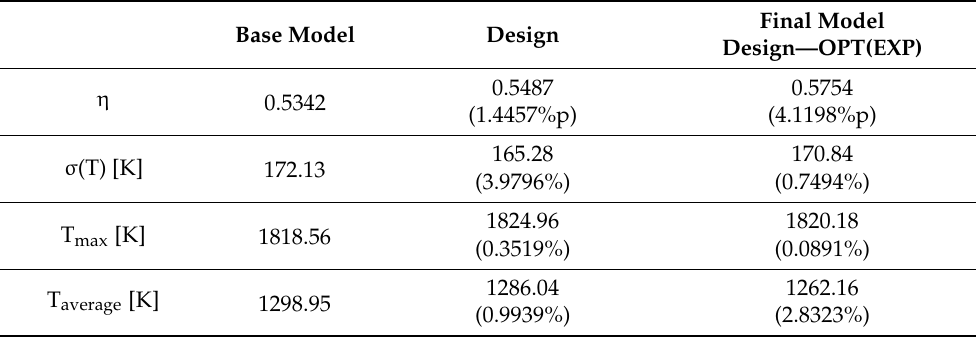
Table 9. Comparison of the cooling performance for the base model, the design in Section 3.1, and the final